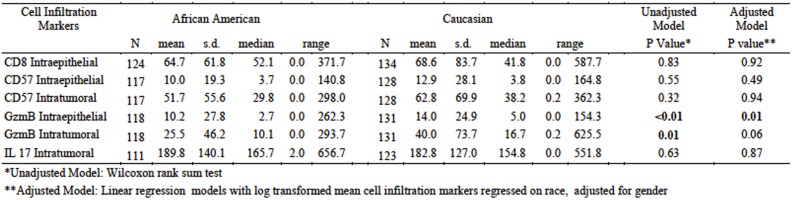
Summary statistics of the six cell infiltration biomarkers by race.The infiltration of cells positive for each of the markers (CD8, CD57, GzmB, and IL-17) are indicated, as is whether the data is for positive cells infiltrating the entire tumor (IT, epithelium and stroma) versus the epithelium alone (IE, intraepithelial).